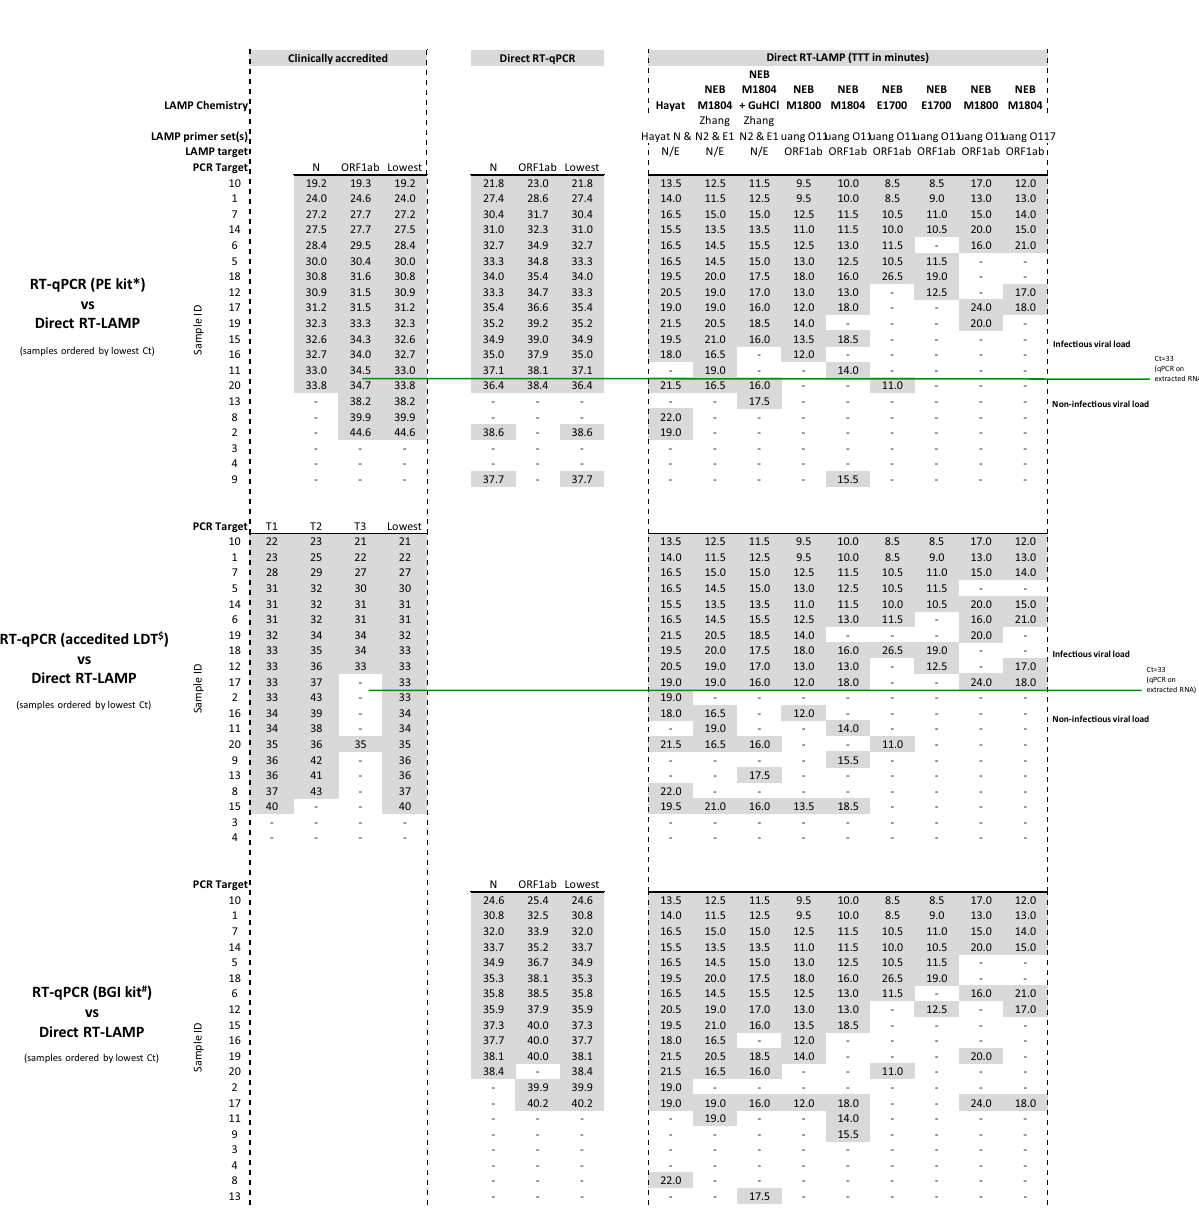
Table 2. Performance of direct RT-LAMP: performance of direct RT-LAMP compared to RT-PCR. In this table, RT-LAMP experiments are ordered (left-to-right) from highest to lowest performer. Performance was measured by the highest Ct below which 100% sensitivity was achieved. All NEB chemistries included added Syto9 for detection by fluorometry. All chemistries, except NEB E1700, were colorimetry capable. Colour changes were consistent with fluorometry results. The percentage of reaction volume consisting of sample in RT-LAMP and direct RT-PCR varied from 3.75 to 5%, according to the specified requirements of each test. Purified RNA input of the Perkin Elmer RT-PCR assay kits constituted two-thirds of the total reaction volume, according to the instructions for use. † ’Clinically accredited test’ is a diagnostic test/protocol authorized by the Therapeutic Goods Administration (TGA) of Australia and/or FDA under an Emergency Use Authorization (EUA) for detection of SARS-CoV-2. *PE kit: PerkinElmer New Coronavirus Nucleic Acid Detection Kit. Each value shown for Direct-PCR with the PE kit is the mean of two independent heat-inactivation experiments. $ Accredited LDT: an accredited laboratory-developed test (LDT) of the Western Australian pathology service laboratory. # BGI kit: BGI Health Real-time fluorescent RT-PCR kit for detecting SARS-CoV-2. TTT: Time to threshold, where threshold is defined as 1.5 × baseline. Dash (–) denotes either no detection of target by 45 cycles of RT-PCR or fluorescence signal did not reach threshold by 30 min in